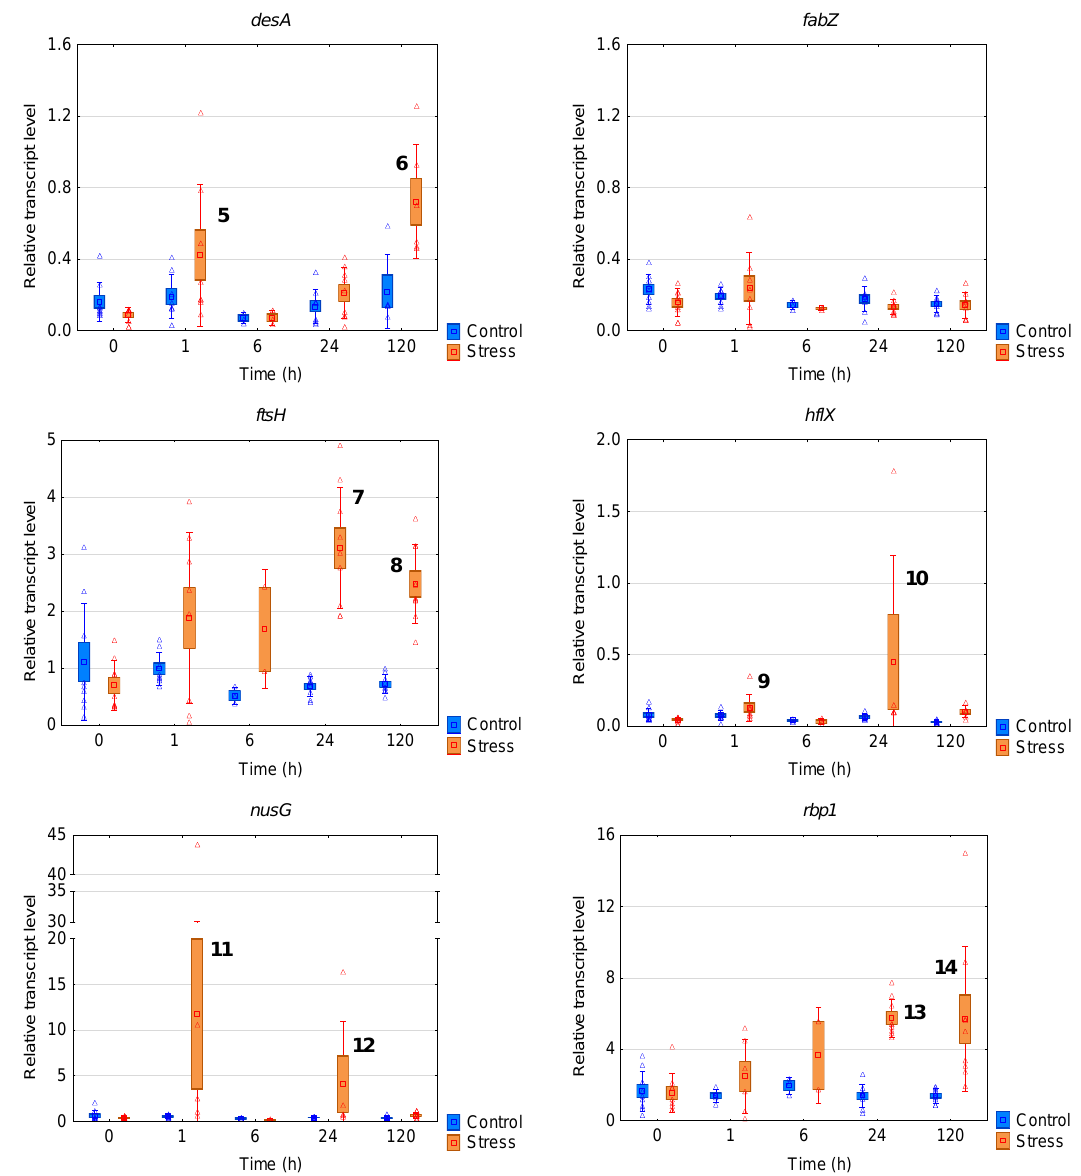
Figure 3. The box plots with a relative gene expression level of each analyzed gene of Raphidiopsis raciborskii AMU-DH-30 in reference to the prs house-keeping gene transcript level. Means are indicated by squares, bars represent standard deviation, whereas boxes represent the standard error. Raw data are marked as triangles. Statistically significant di ff erences: (1) increased in comparison to stress t0, control 1, 24, and 120 h; (2) increased in comparison to stress t0, control t0, 1, 24, and 120 h; (3) increased in comparison to stress t0, control t0, 1, 24, and 120 h; (4) increased in comparison to each control, stress t0 and 120 h; (5) increased in comparison to each control; (6) increased in comparison to each control, stress t0, 6, 24, and 120 h; (7,8) increased in comparison to each control and stress t0; (9) increased in comparison to each control and stress; (10) increased in comparison to each control and stress 6 h; (11,12) increased in comparison to each control and stress t0; (13, 14) increased in comparison to each control, stress t0, and 1